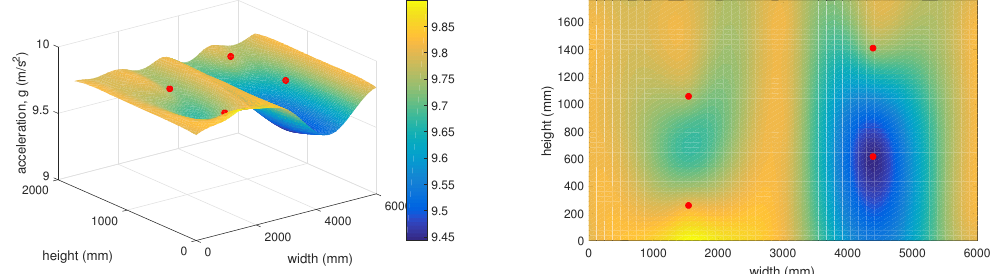
Figure 18. Vector sum of acceleration at 10:48.